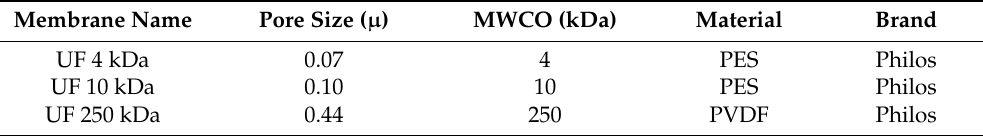
Table 2. Properties of UF membranes.